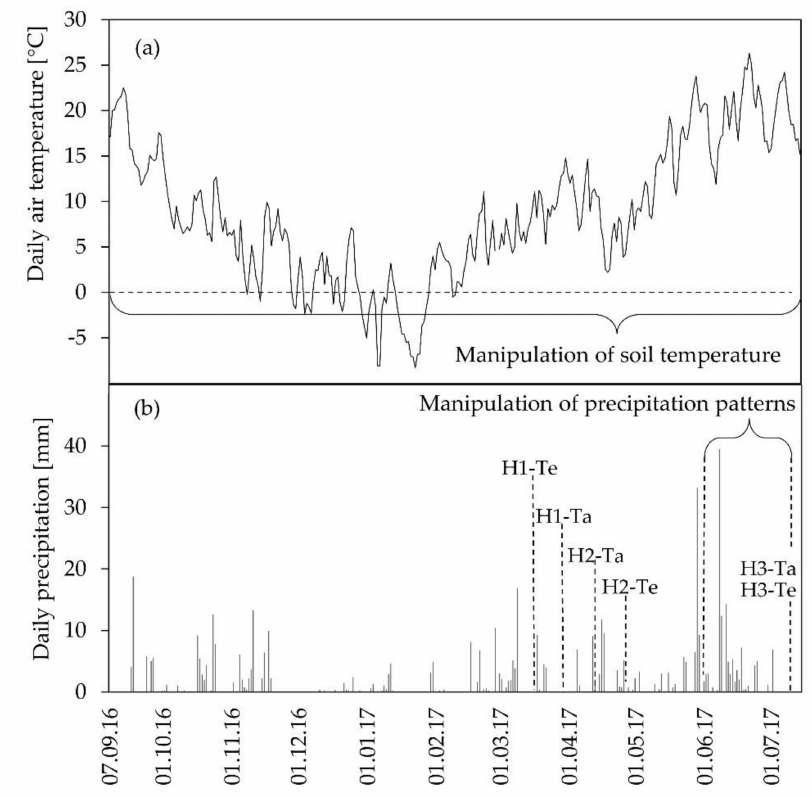
Figure 1. ( a ) Average daily air temperature at 2 m height and ( b ) daily precipitation at the experimental site during the growing season of winter oilseed rape (OSR) from 7 September 2016 to 11 July 2017.